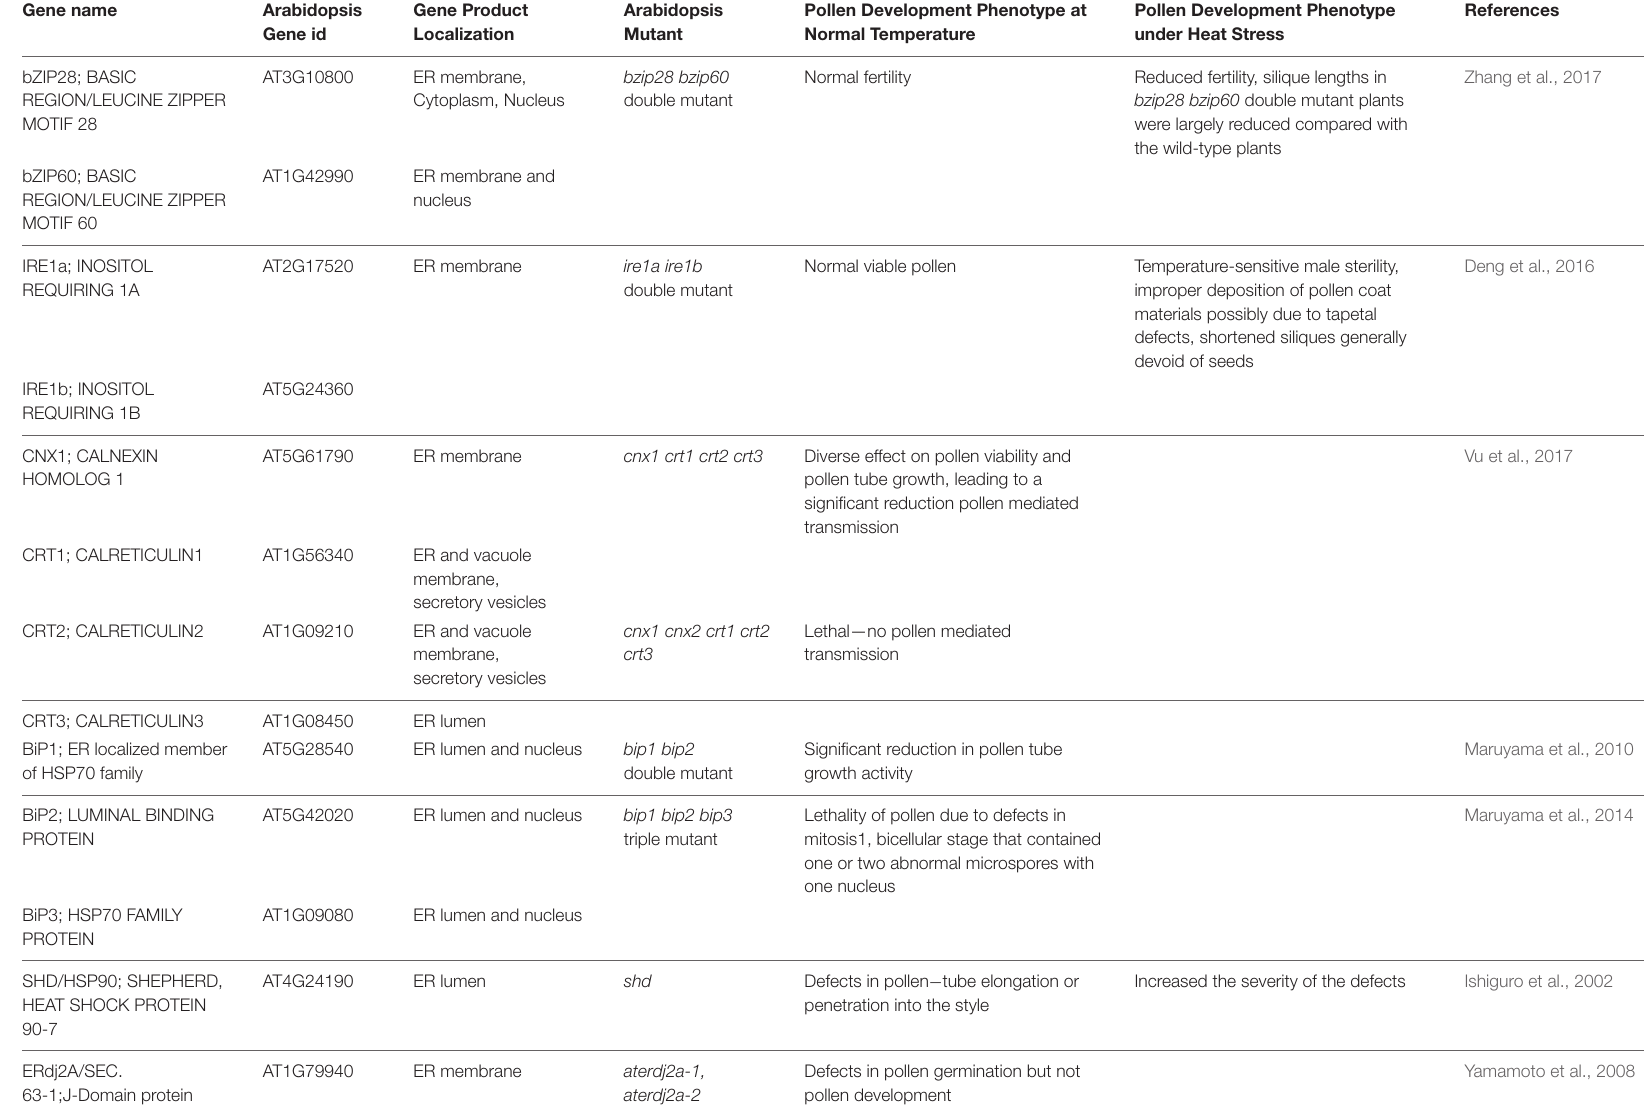
TABLE 1 | A summary of Arabidopsis ER stress response genes and roles as determined by fertility phenotypes in gene knockout